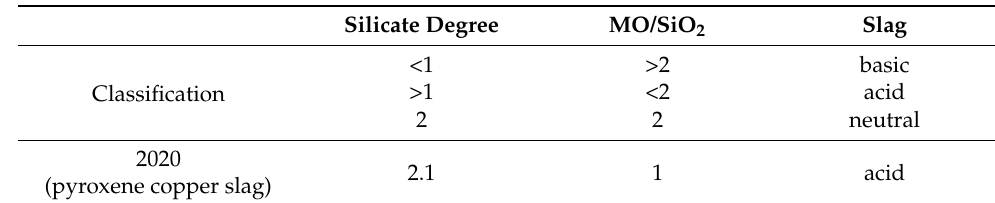
Table 8. Classification of nonferrous slags.